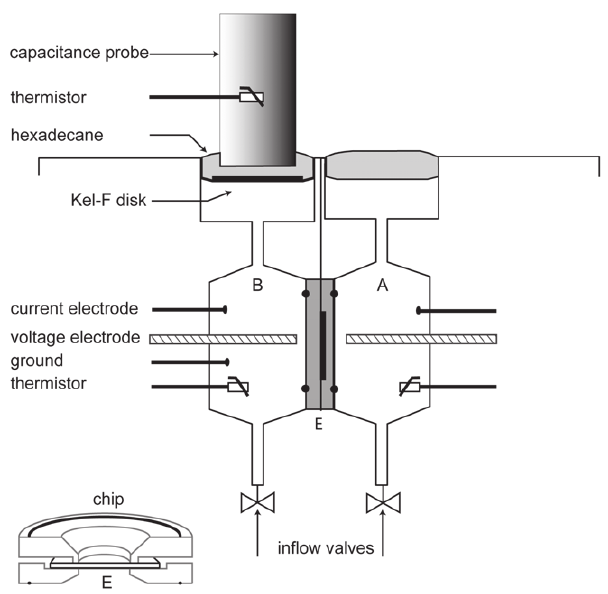
Figure 2. Schematic diagram of fluid transport chamber. Top part of figure shows internal chamber design consisting of two identical hemichambers. Each hemichamber has a voltage-sensing electrode, three current-passing electrodes, and a thermistor. Hemichamber A contains media bathing the apical or retinal surface; hemichamber B contains solution bathing the basal or choroidal surface. Surface of each bathing solution is covered with hexadecane to eliminate evaporation. A capacitance probe is immersed in the hexadecane in one hemichamber. Volume change is detected by changes of distance between probe and bathing media surface. Solutions are exchanged by gravity flow from reservoirs through inflow valves at the bottom and suction from the surface on top. A thin Kel-F disc (dark horizontal line) is used to isolate probe tip from media and avoid short circuit. RPE monolayer (E) is mounted between two circular Kel-F discs with O-rings (shown in lower left corner of the figure). This chip is mounted between two water-jacketed Kel-F blocks in main chamber located in a modified CO 2 incubator (5% CO 2 , 36.5 u C) for fluid transport ( J v) measurements.